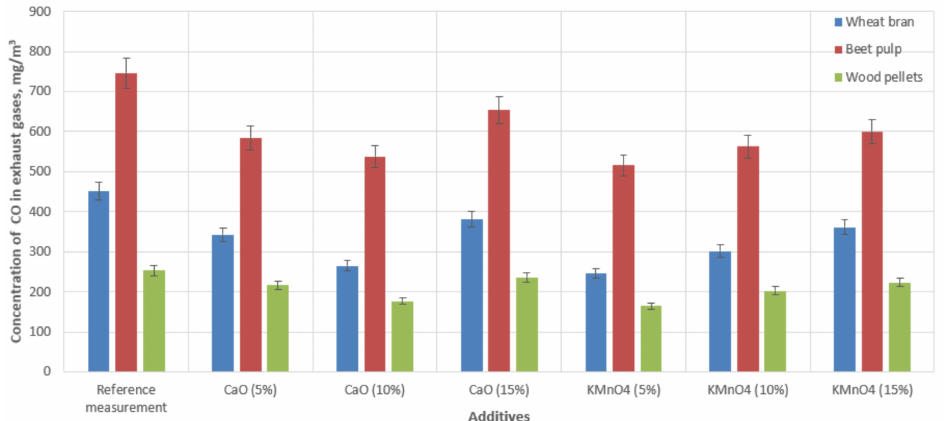
Figure 4. Concentrations of carbon monoxide in the flue gas of a low-power boiler while burning biomass with catalytic